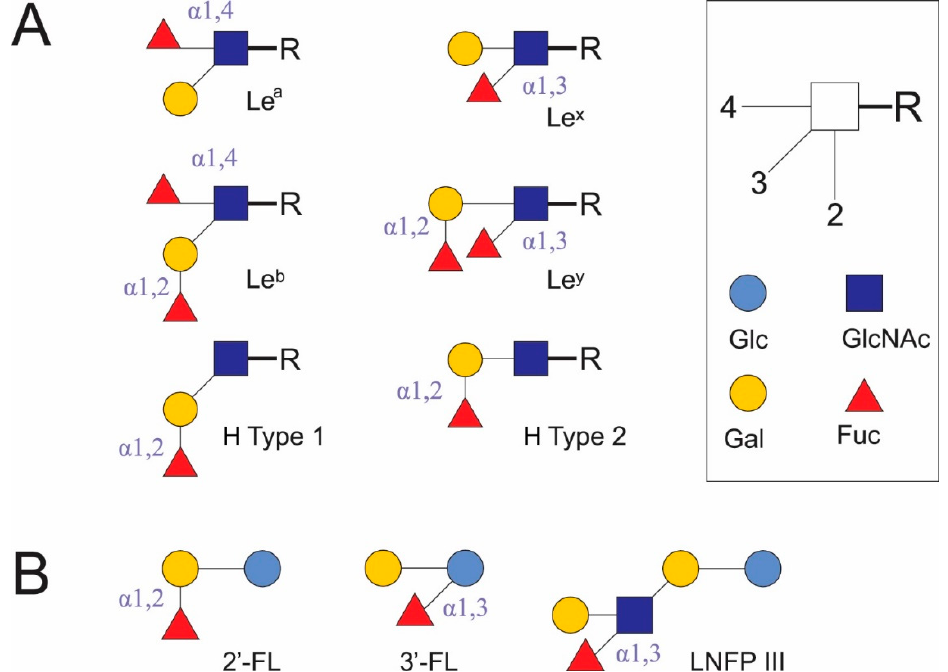
Figure 1. Fucosylated glycoconjugates ( A ) and some human milk oligosaccharides ( B ), which may act as unique carbohydrate patterns. Fuc: L-fucose. Gal: galactose. Glc: glucose. GlcNAc: N -acetyl-D-glucosamine. Le a : Lewis a antigen. Le b : Lewis b antigen. Le x : Lewis x antigen. Le y : Lewis y antigen. H type 1: H antigen type 1. H type 2: H antigen type 2. 2 ′ -FL: 2 ′ -fucosyllactose. 3 ′ -FL: 3 ′ -fucosyllactose. LNFP III: lacto- N -fucopentaose III.